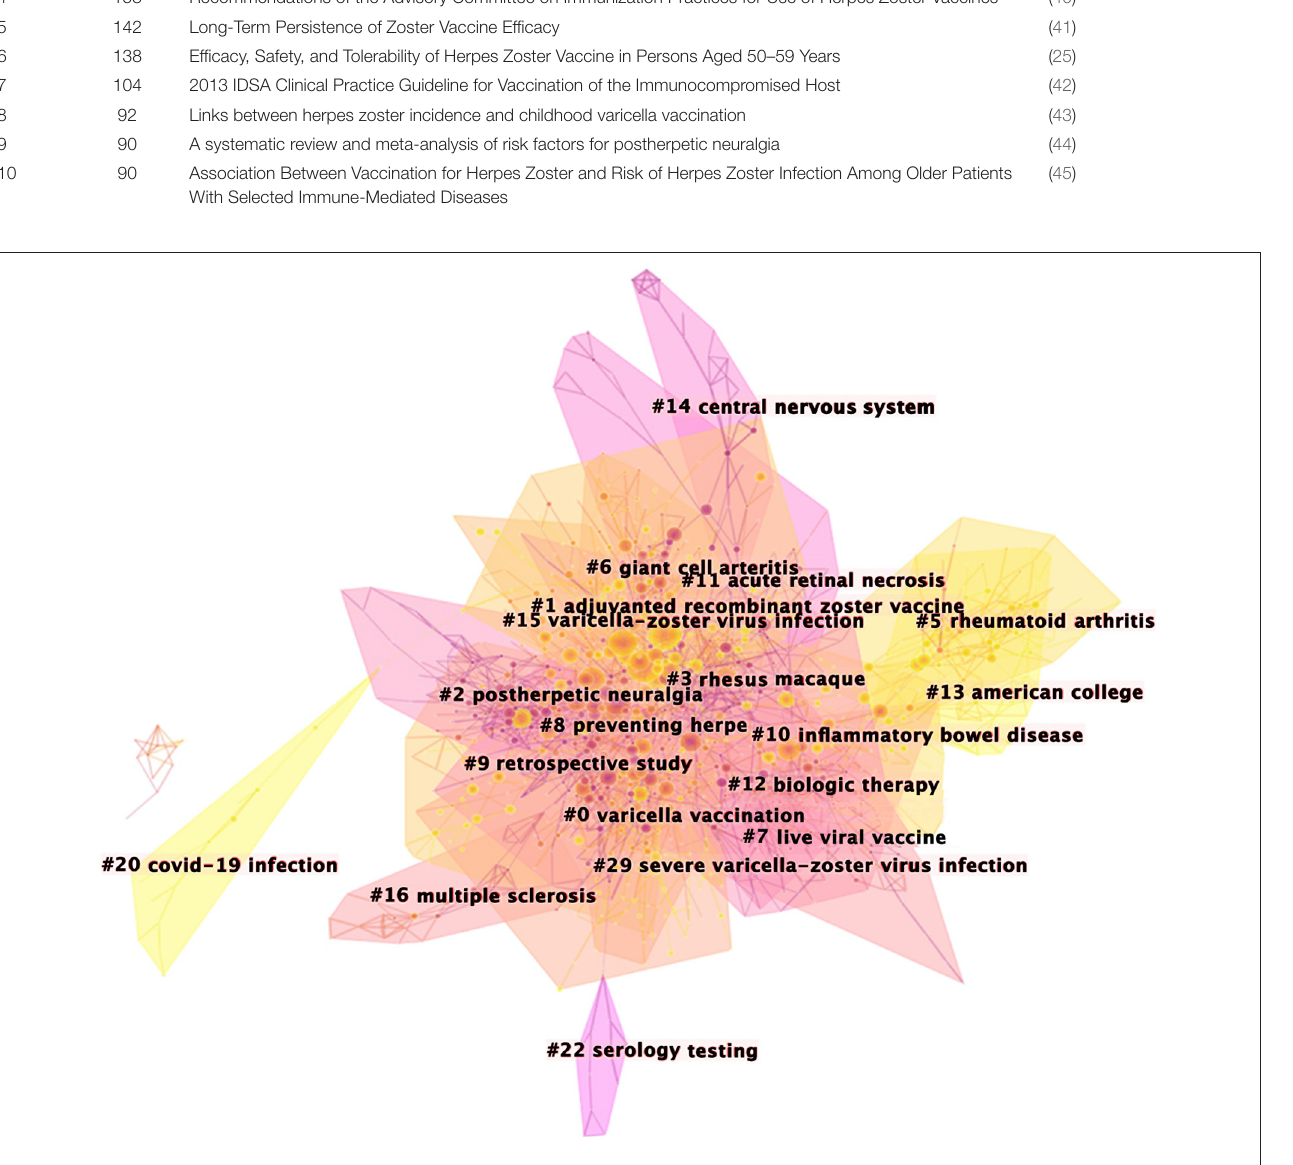
FIGURE 4 | The clustered network map of co-cited references on herpes